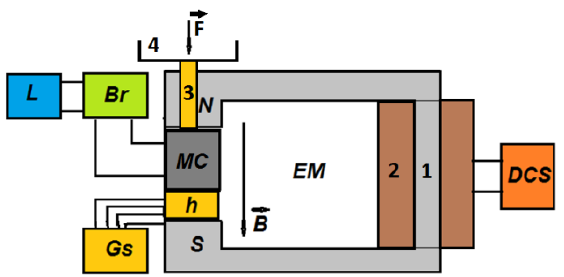
Figure 4. Experimental setup (overall configuration): EM, electromagnet; N and S, magnetic poles; MC, flat capacitor; F , compression force; B , magnetic flux density; DCS, direct current source; Br, RLC bridge; Gs, Gaussmeter; h, Hall probe; L, computational unit. 1: magnetic core; 2: coil; 3: brass shaft; 4: non-magnetic disc. Note: Dimensional proportions of setup components are not accurate.